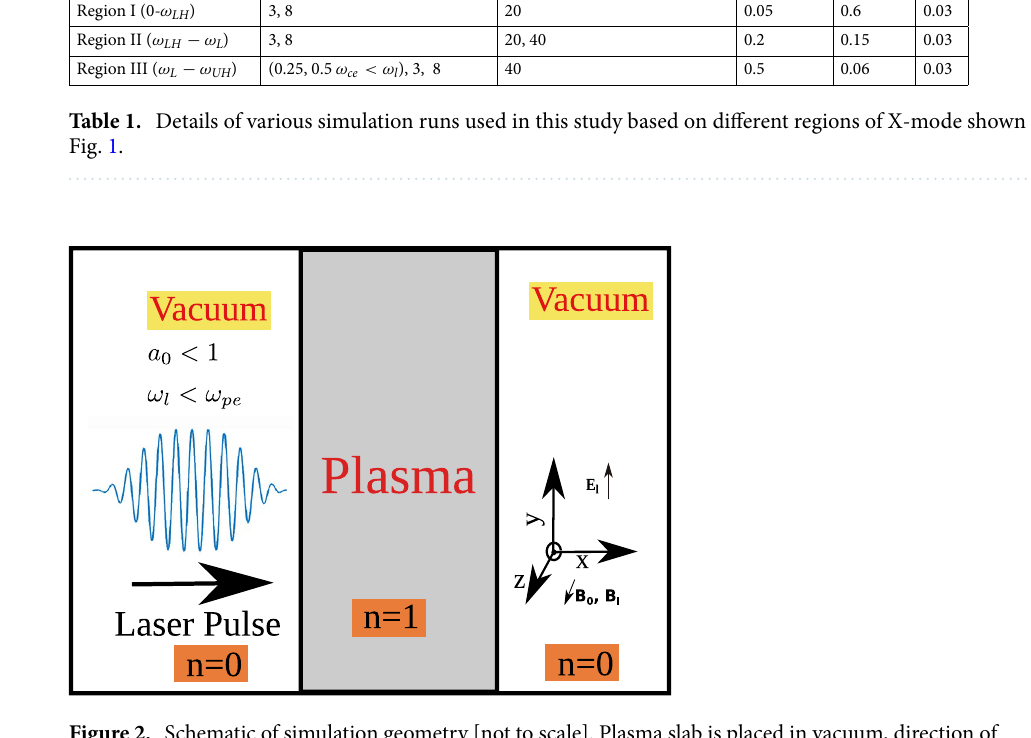
Figure 2. Schematic of simulation geometry [not to scale]. Plasma slab is placed in vacuum, direction of external Magnetic field ( B 0 ) is along the same direction as that of the magnetic field of laser ( B l ) i.e. ˆ z . Electric field of laser is along ˆ y direction. a 0 is normalized vector potential i.e. ( eE 0 / m ω c ). This parameter decides the regime of plasma dynamics, in this work we have taken a 0 < 1 i.e. non-relativistic regime. In this schematic, ‘n’ denotes plasma